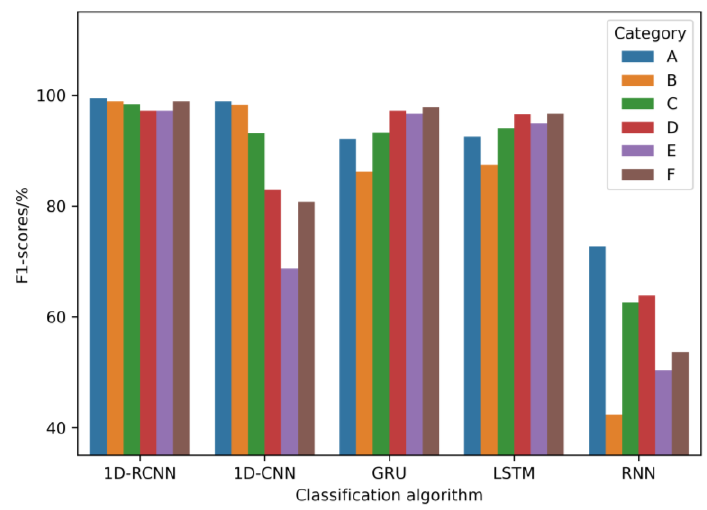
Figure 10. F 1 -score bar plots for each model ’s classification recognition (unit: %).